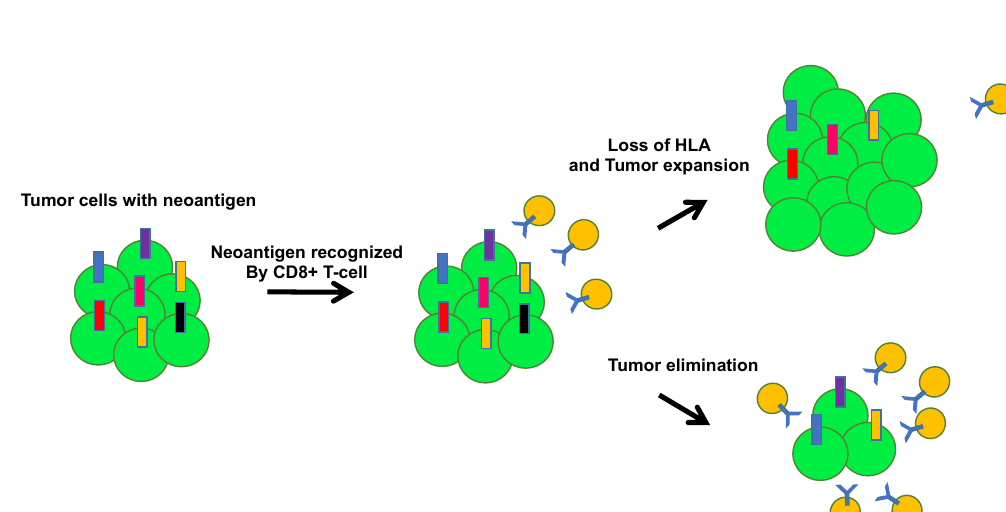
Figure 5. Tumor escape through human leukocyte antigen (HLA) loss. HLA loss allows tumor cells to escape the immune system. During tumor evolution, the accumulation of tumor neoantigens induces local immune infiltration. Tumor cells with HLA loss can be positively selected by avoiding CD8 T cell recognition.